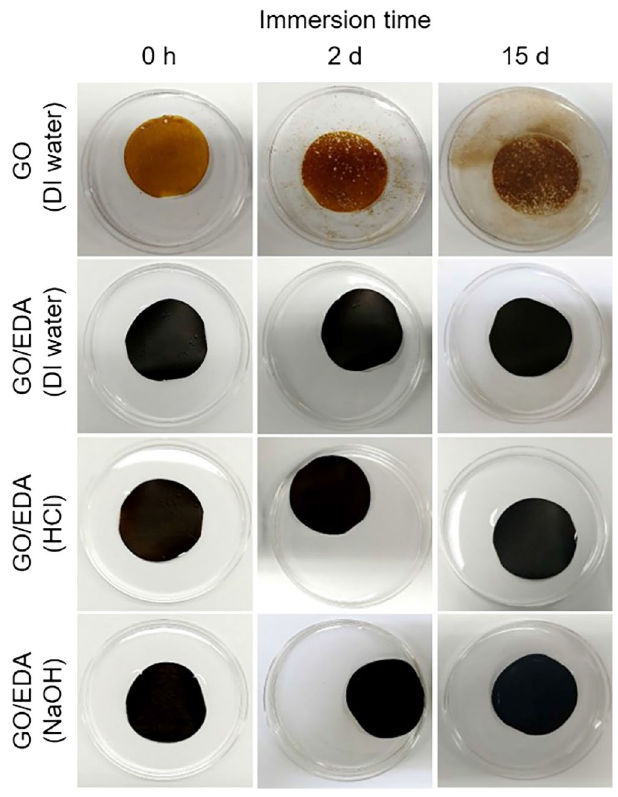
Figure 6. Stability of GO and GO/EDA coatings in aqueous solvents including water. The exposure time of EDA was 1 h. The concentration of HCl and NaOH solutions was 1